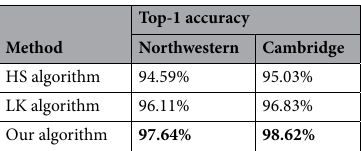
Table 9. Accuracy comparison of optical flow algorithm. Significant values are in bold.